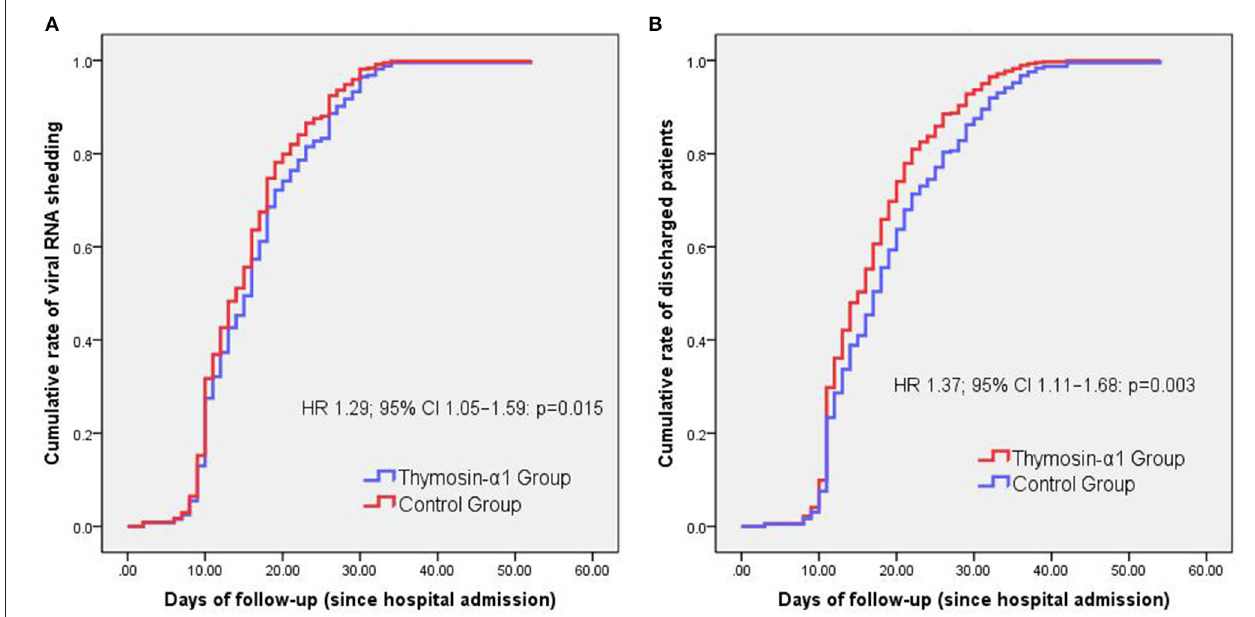
FIGURE 1 | Cox analysis for comparison of time variables between groups. The only one patient who died was excluded when we compared the cumulative rates of discharged patients over days of follow-up between groups. Thymosin- α 1 therapy is associated with a shorter SARS-CoV-2 RNA shedding duration (HR 1.29; 95% CI 1.05–1.59: p = 0.015) (A) and hospital stay (HR 1.37; 95% CI 1.11–1.68: p = 0.003) (B) , compared with the control